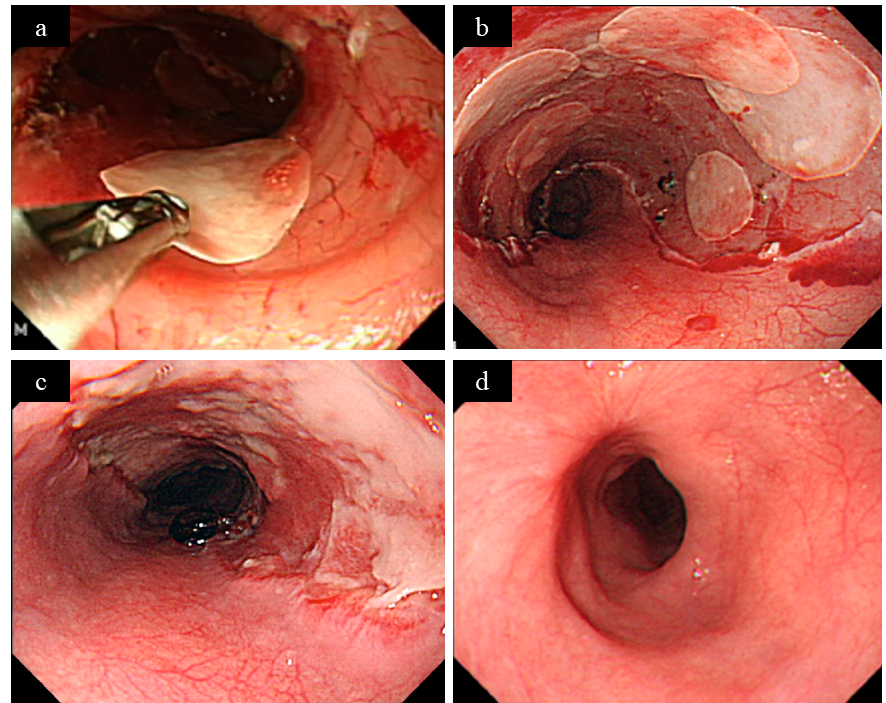
Figure 3. A case of autologous oral mucosal sheet transplantation (courtesy of Dr. Ohki of Tokyo Women’s Medical University). ( a ) Oral mucosal sheets were implanted in the mucosal defect after endoscopic submucosal dissection (ESD) using grasping forceps. ( b ) Transplantation with seven